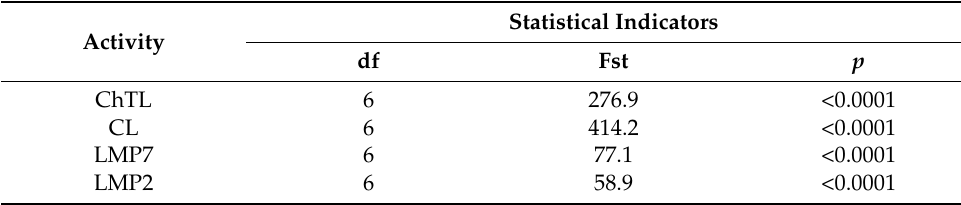
Table 2. Dependence of proteasome activities on the location in the